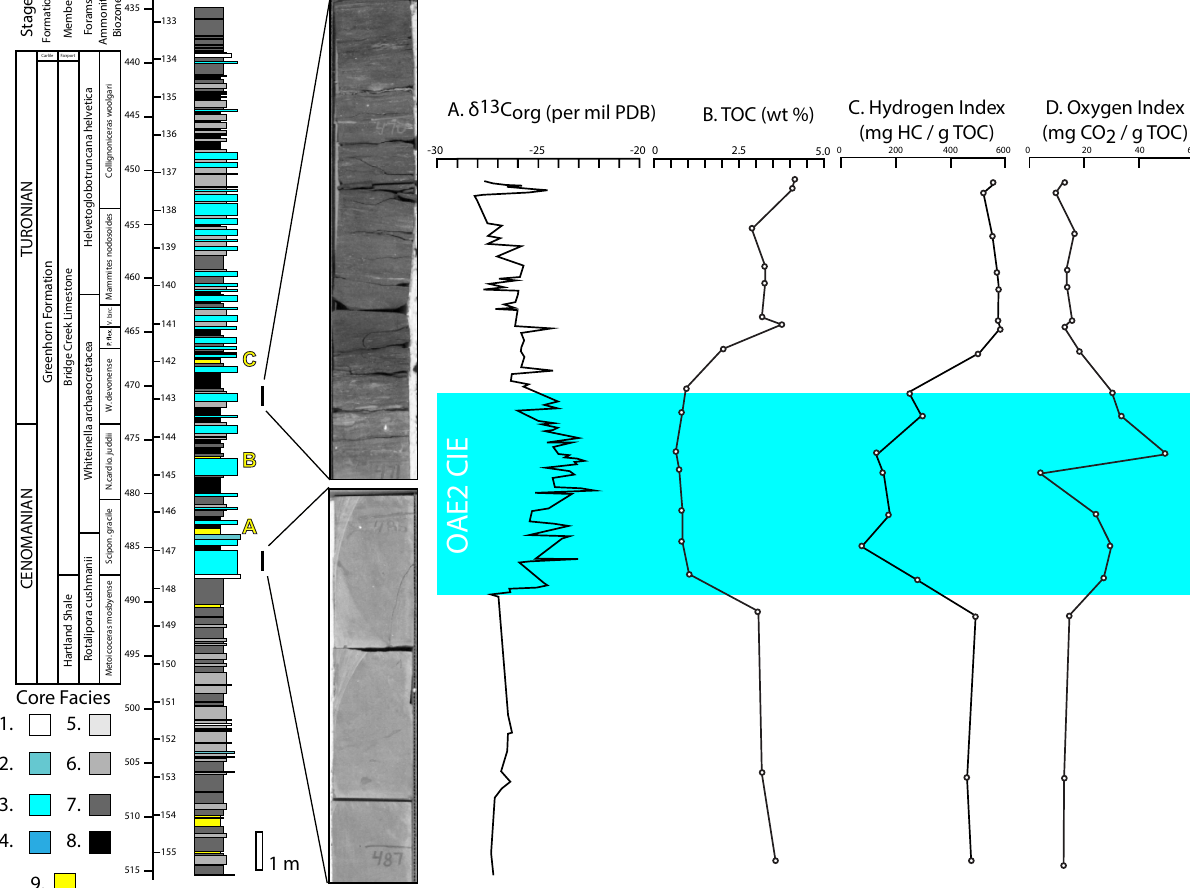
Figure 2. USGS Portland-1 core lithologic section, carbon isotope profile and RockEval data. Facies Explanation: 1. Peloidal/foraminiferal, packstone/grainstone; 2. Bioturbated peloidal packstone; 3. Bioturbated peloidal wackestone; 4. Skeletal grainstone; 5. Rippled mudstone; 6. Silty laminated mudstone; 7. Diffusely laminated mudstone; 8. Massive mudstone; 9. Bentonite. Samples were limited to facies 7 and 8. The occurrence of bioturbated peloidal carbonates during the OAE2 CIE indicates that the environment at the time of deposition was oxygenated and supported a diversity of tropical marine life. Note that the core is measured in imperial units as the Portland-1 core and core photos are curated with imperial measurements. This reference is preserved here in the case that the reader wishes to cross-reference these results to the Portland-1 core. Radioisotopic measurements from bentonites A, B, and C, along with biostratigraphy and correlation of depositional cycles to orbital timescales have produced an average sedimentation rate of 0.93 cm/kyr during the OAE2 CIE 19–21 . The interval of samples with the greatest flux in measured biomarker concentration occurs from ca. 473 feet to ca. 479 feet, in the central portion of the OAE2 CIE. Sample spacing in this interval is somewhat irregular in order to stay within the same depositional facies, but varies between 3 and 12 cm indicating that rapid flux in organic geochemical composition of analyzed sediments over periods approximately 3–15 kyr. The carbon isotopic excursion (CIE) that defines OAE2 is shown on the δ 13 C track and highlighted in blue on all compound tracks 20 . Hydrogen Index (HI) is generally negatively correlated with depositional environment oxygen concentrations, thus supporting the trend of OAE 2 CIE oxygenation. Oxygen Index (OI) generally correlates positively with depositional environment oxygen concentrations, and again provides evidence for oxygenation during the OAE2